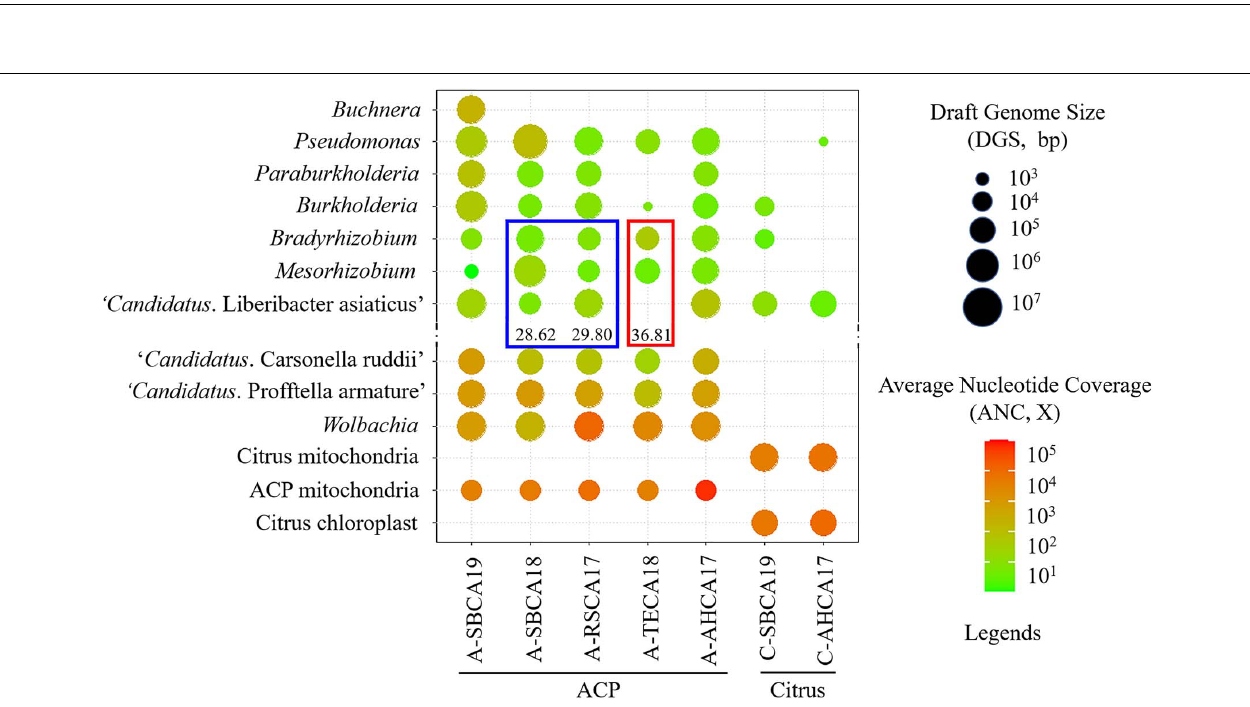
FIGURE 2 | Graphical representation of draft genomes of ACP-associated bacteria (AABacts) and citrus-associated bacteria (CABacts) as listed in Supplementary Tables 1 , 2 . Draft genome size (DGS) is coded by circle sizes; average nucleotide coverage (ANC) is coded by colors. The blue box highlights the comparison of three bacteria in two samples with “ Candidatus Liberibacter asiaticus” (CLas) in TaqMan HLBaspr-PCR Ct values near 30. The red box highlights the comparison of three bacteria in a single sample where CLas was not detected but shows TaqMan HLBaspr-PCR Ct values.